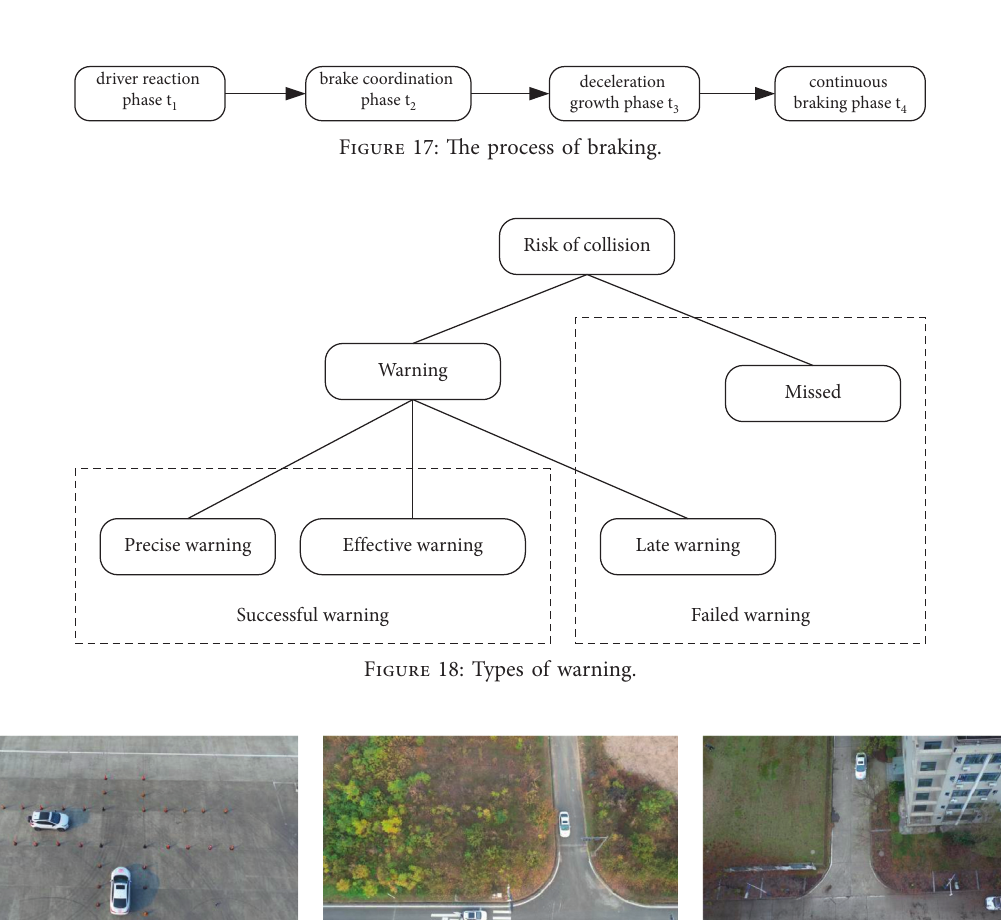
Figure 16: V2V-based intersection collision scenario.